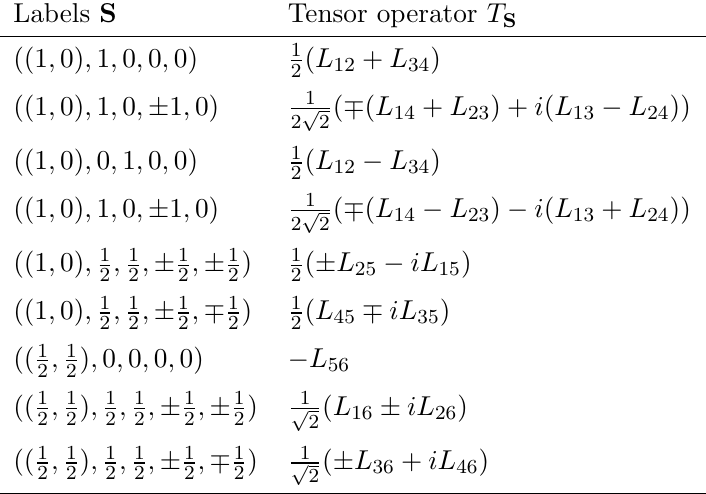
Table 7 . Relation between the tensor operators of so (6) and the corresponding generators L ij